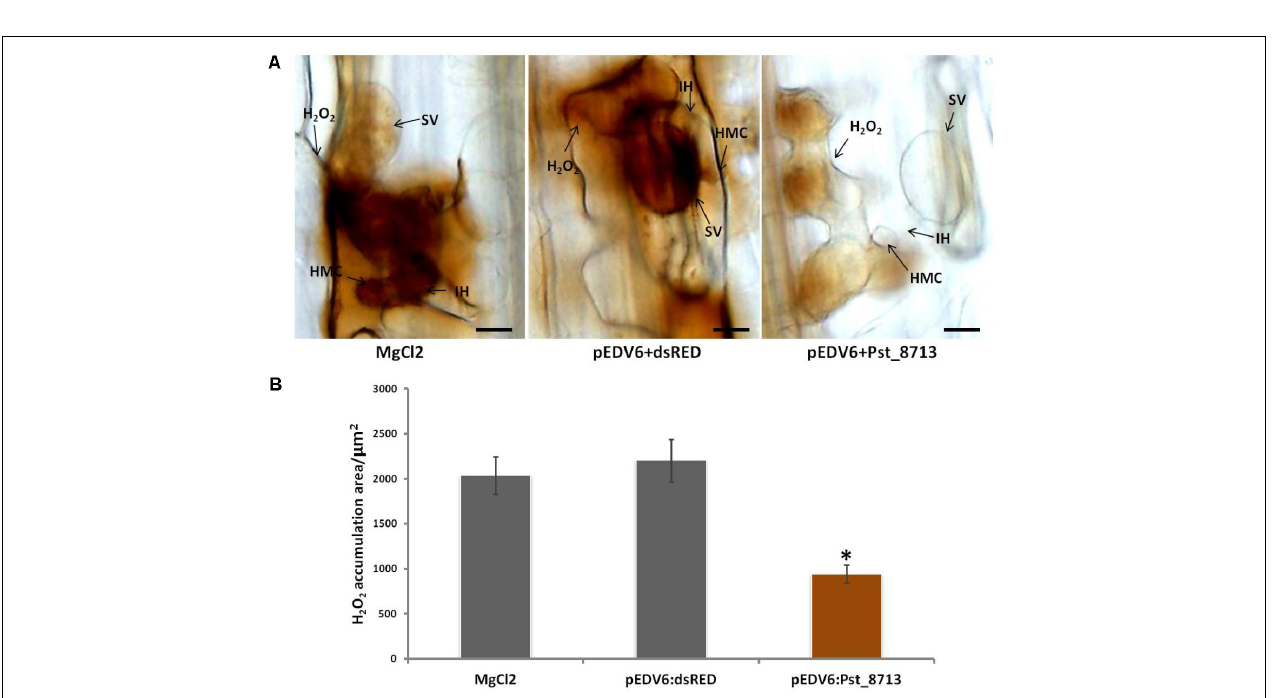
FIGURE 7 | Overexpression of Pst_8713 suppressed ETI associated ROS in wheat Suwon11. (A) H 2 O 2 accumulation at 24 hpi in wheat leaves infiltrated with MgCl 2 buffer, pEDV6:dsRED, or pEDV6:Pst_8713, and 24 h later inoculated with the avirulent Pst isolate CYR23. After being stained with DAB, the samples were viewed under differential interference contrast optics. Bar = 10 µ m. (B) Statistics of H 2 O 2 accumulation area/ µ m 2 in wheat leaves inoculated with CYR23 24 hpi after infiltrated with MgCl 2 buffer, pEDV6:dsRED, or pEDV6:Pst_8713. Bars indicate means ± SE of three independent biological replicates with 30 infection sites per replicate. Asterisks indicate significant differences ( P < 0.05) relative to the pEDV6:dsRED sample using Student’s t -test.